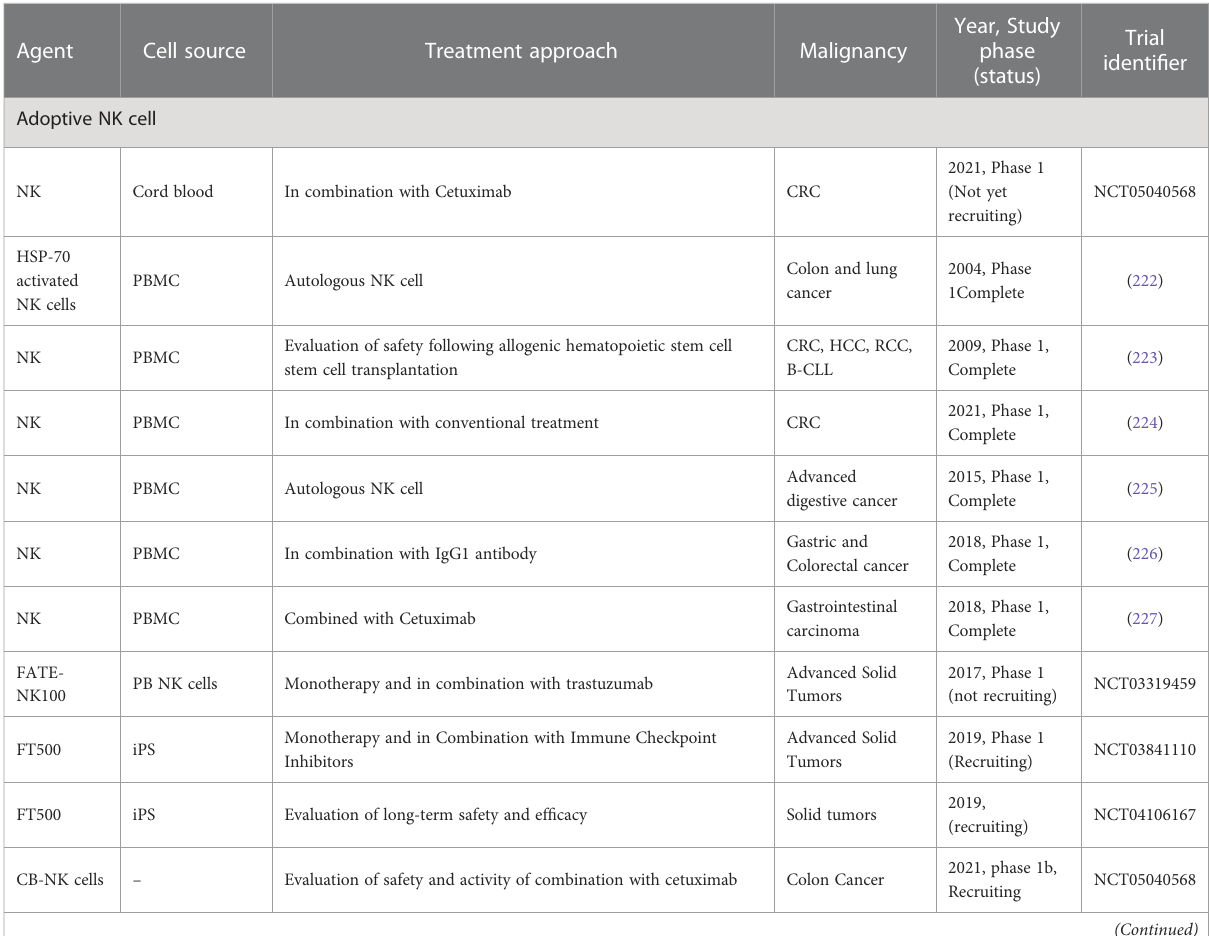
TABLE 4 Ongoing clinical trials of therapeutic NK cells in